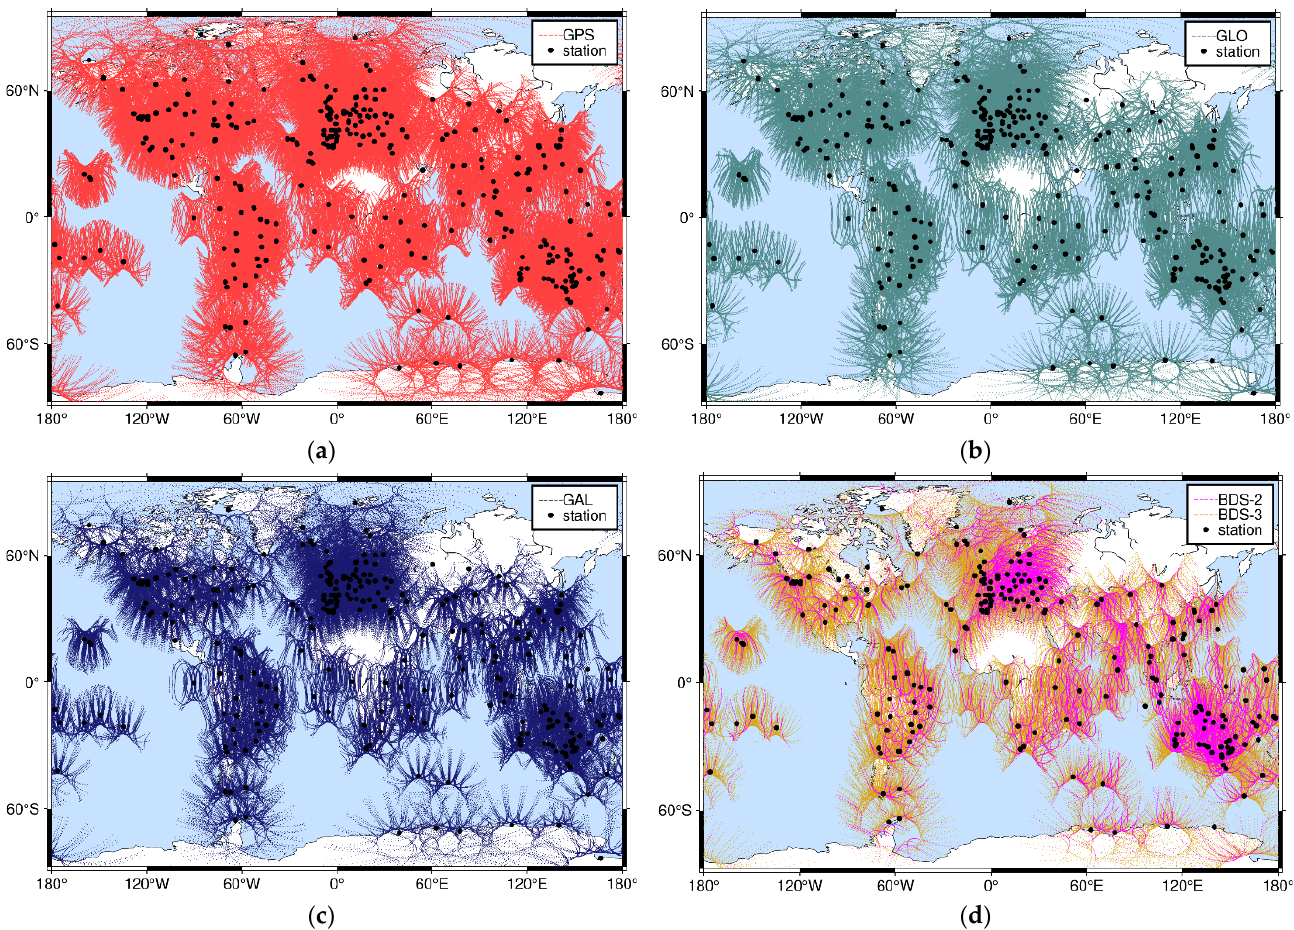
Figure 3. IPPs distribution of ( a ) GPS, ( b ) GLONASS, ( c ) Galileo and ( d ) BDS.